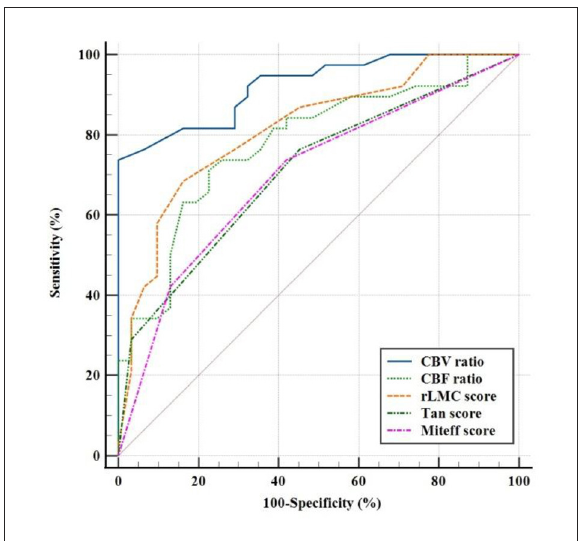
FIGURE4 Receiver operating characteristic curves showed sensitivity and specificity in predicting a good clinical outcome with three qualitative assessments of CS and CTP